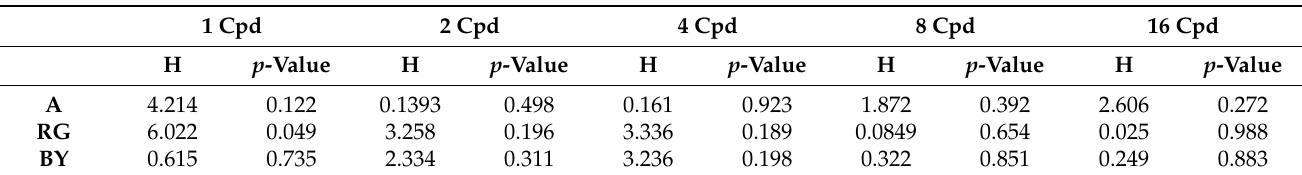
Figure 4. Chromatic monocular CSFs. Median and interquartile range for three groups: 0 = control (blue), 1 = moderated smokers (orange), and 2 = severe smokers (grey): ( a ) RG mechanism, ( b ) BY mechanism.